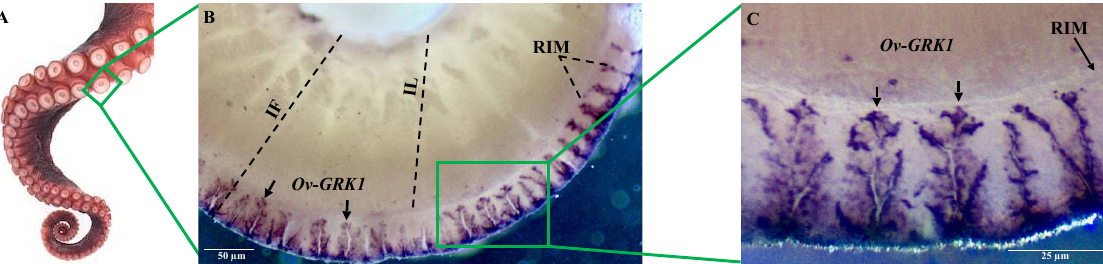
Figure 3. Whole-mount in situ hybridization of the Ov-GRK1 gene in the rim of an O. vulgaris middle sucker. ( A ) Octopus arm with array of suckers; ( B ) the receptor expression is present in the epithelium of the rim (arrows); ( C ) higher magnification of the portion of the epithelium rim inside the green rectangle showing Ov-GRK1 expression. Sucker rim epithelium (RIM), sucker infundibulum (IF), infundibulum lumen (IL). Arrows indicate positive signals.